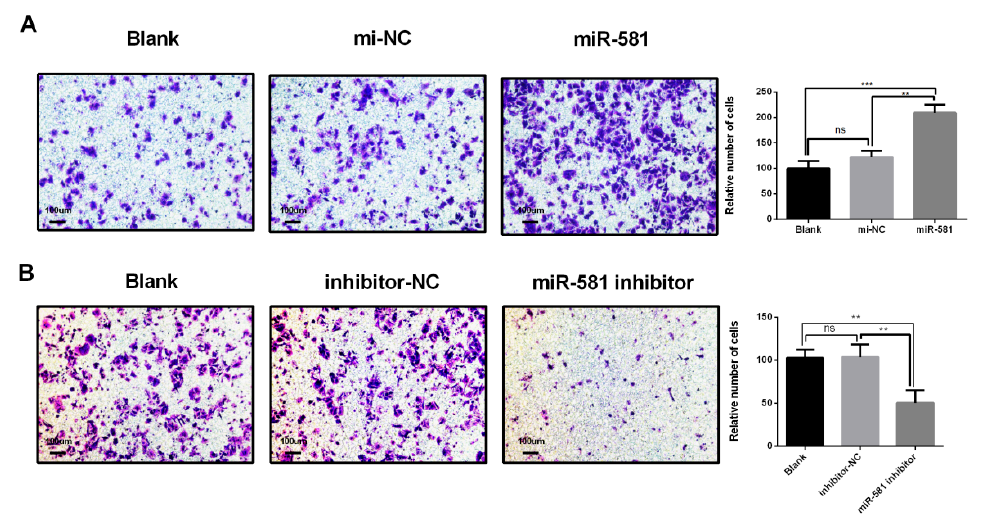
Figure 5. MiR-581 promotes cell invasion capacity. ( A ) MiR-581 overexpressing SW480 cell invasion capacity, as detected by transwell assay (100 × ). ( B ) MiR-581-depletion SW480 cell invasion capacity, as detected by transwell assay (100 × ). Relative number of invaded cells is shown in the histogram. ** p < 0.01 and *** p < 0.001.